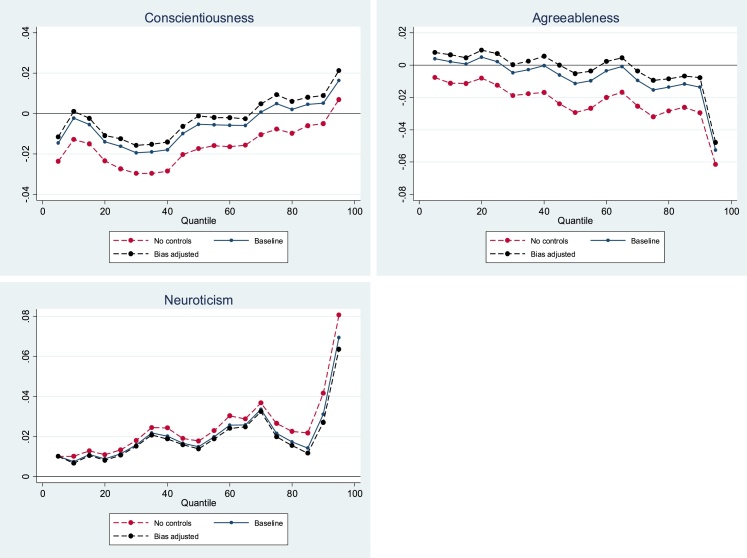
Adolescent non-cognitive skills – allostatic load omitted variable bias adjusted relationship.